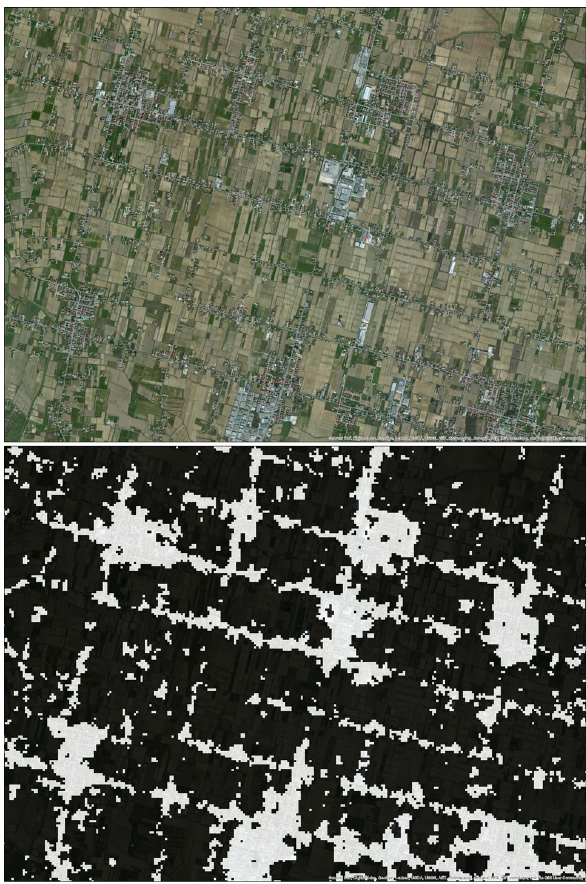
Figure 2: Example of built-up areas extracted from Landsat data processing in the GHSL workflow in the Veneto region (Italy). Top: high resolution image of a scattered settlement pattern. Bot- tom: output of the automatic recognition of built-up areas using 30-m-resolution input Landsat data.